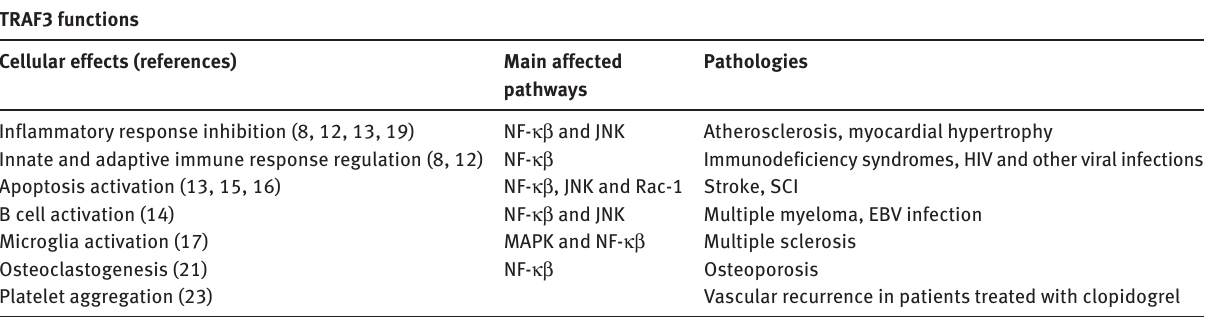
Table 1: TRAF3 functions at the cellular level, main affected pathways and pathologies associated with each function. TRAF3 functions